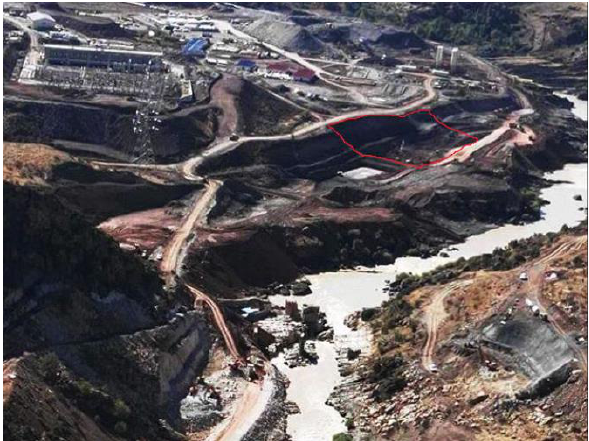
Figure 1. Deralok hydropower planet site, red boundary is power